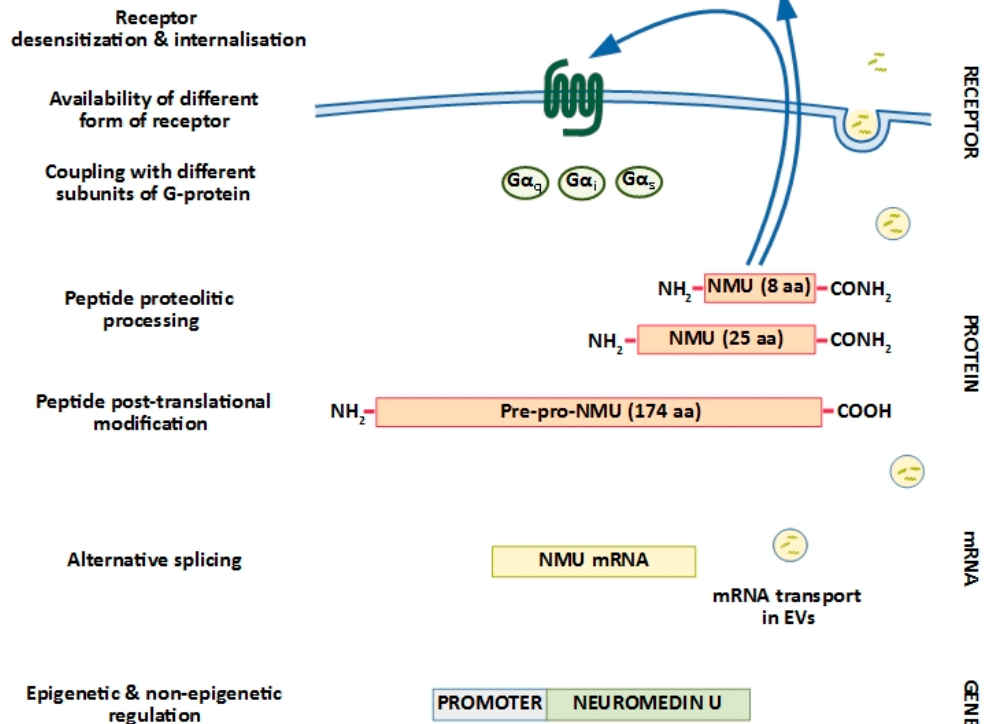
Figure 2. NMU expression and activity is regulated at multiple cellular levels.